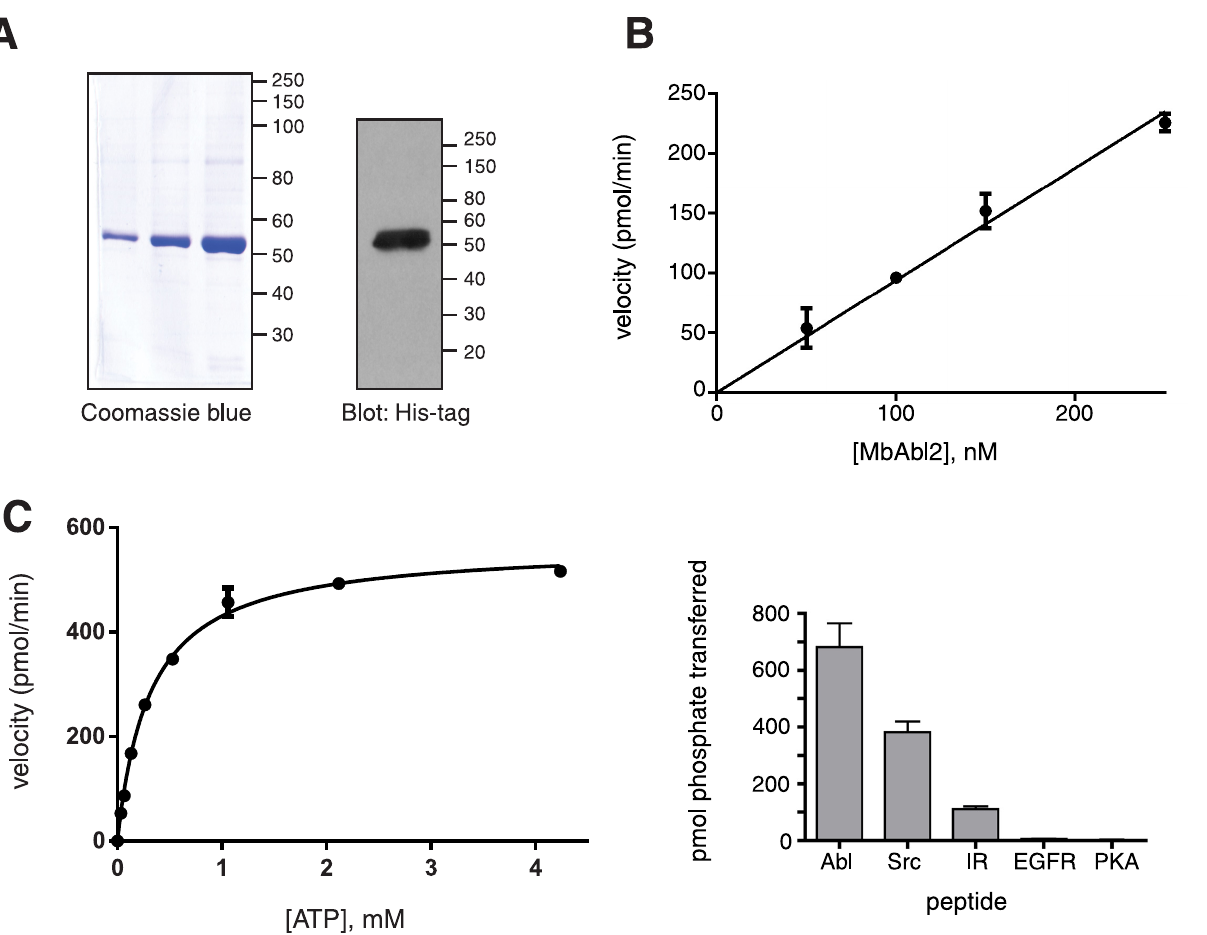
Fig 2. Enzymatic activity of MbAbl2. (A) SDS-PAGE analysis of purified MbAbl2, detected by Coomassie blue staining (left) or by anti-His-tag Western blotting (right). (B) Initial rates of substrate phosphorylation for various concentrations of MbAbl2 were measured in triplicate by the continuous spectrophotometric assay. The peptide substrate used, Abl peptide (EAIYAAPFAKKKG), was at a concentration of 100 μ M. Error bars show standard deviations. (C) MbAbl2 initial rates were measured at varying concentrations of ATP using the continuous spectrophotometric assay. The fit to a hyperbolic substrate vs. velocity curve is shown. (D) MbAbl2-catalyzed phosphorylation of peptide substrates containing recognition motifs for various kinases. The peptide sequences are given in the Materials and Methods section. Enzymatic activity was measured using the phosphocellulose paper binding assay, with an enzyme concentration of 275 nM and peptide concentrations of 500 μ M. Reactions proceeded for 10 minutes at 30°C. Error bars show standard deviation.